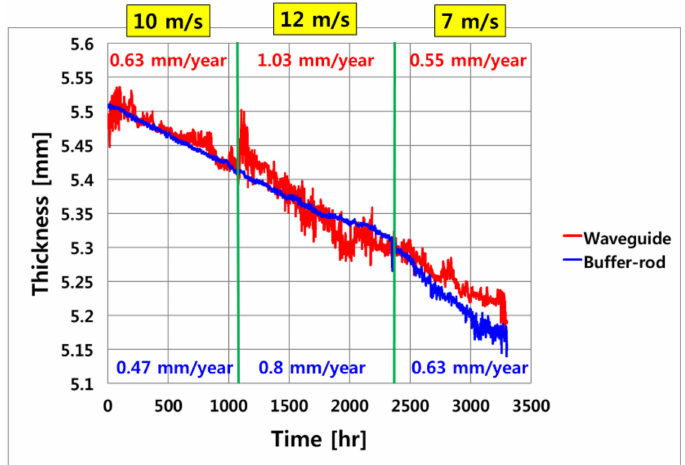
Figure 8. The pipe thickness measurement data using the bu ff er-rod and waveguide type